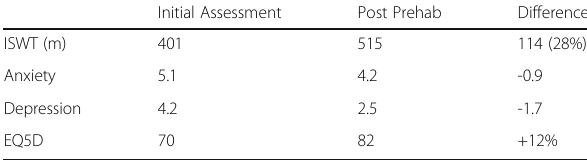
Table 86 (abstract A281). Prehabilitation